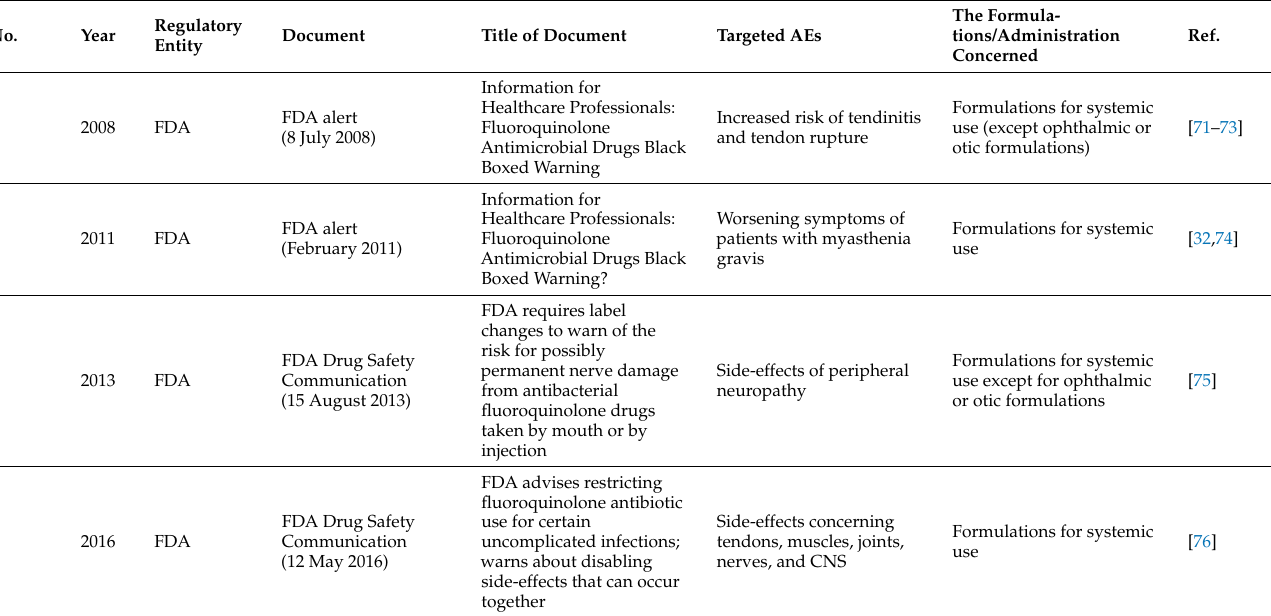
Table 2. FDA and EMA warnings concerning emerging severe AEs of QNs and FQs (AEs—adverse effects, EMA—European Medicine Agency, FDA—USA Food and Drug Administration,